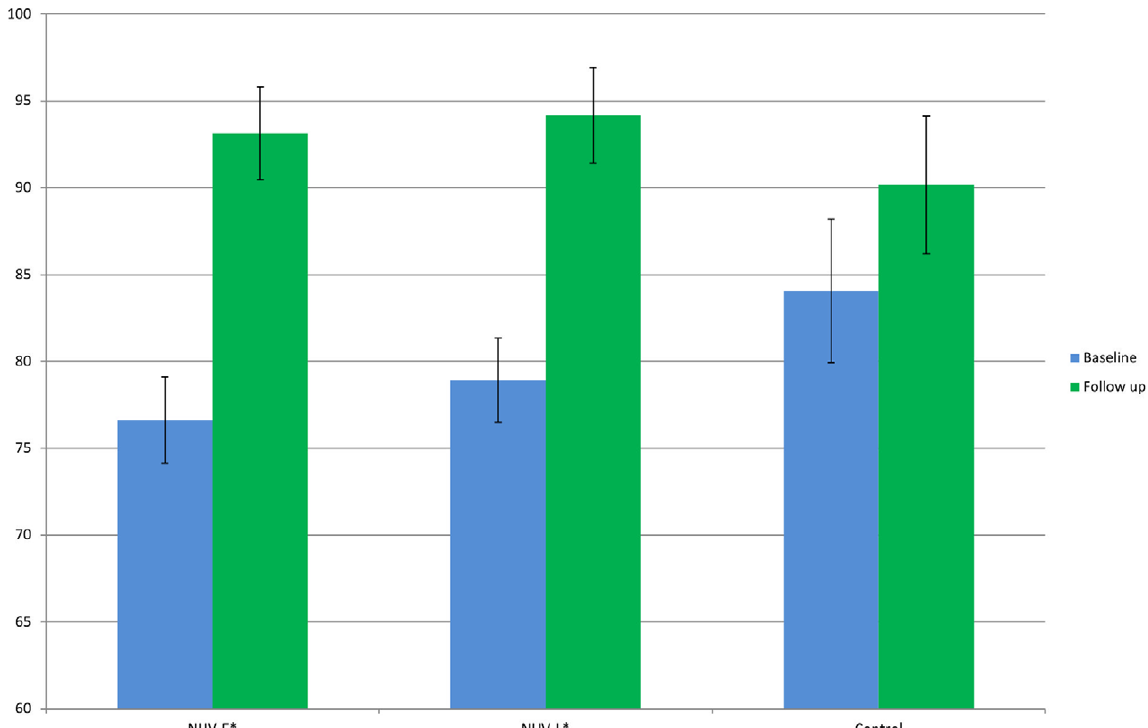
Figure 4. Marginal predictions of Barthel Index mean scores for the NHV study groups at time points based on the three-level Tobit